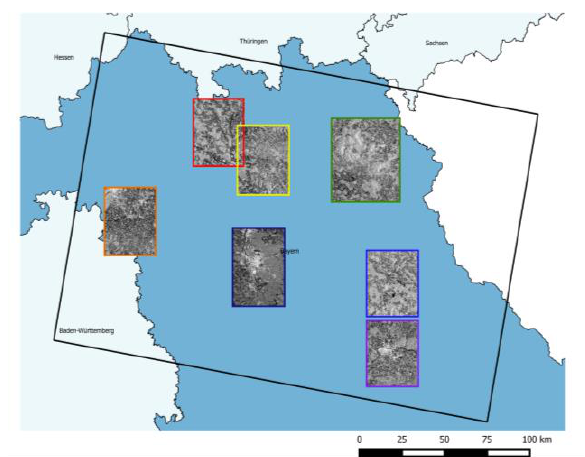
Figure 3. Spatial coverage of the seven subsets chosen as training for the classifier. The black rectangle represents the extent of the original SAR image from Fig. 2. The test sites numbers are represented by the colour of the subset border, varying as per the rainbow from Violet to Red. This means the border for e.g. Test site No.1 is Violet and Test site No. 7 is Red. Background map © BKG open data